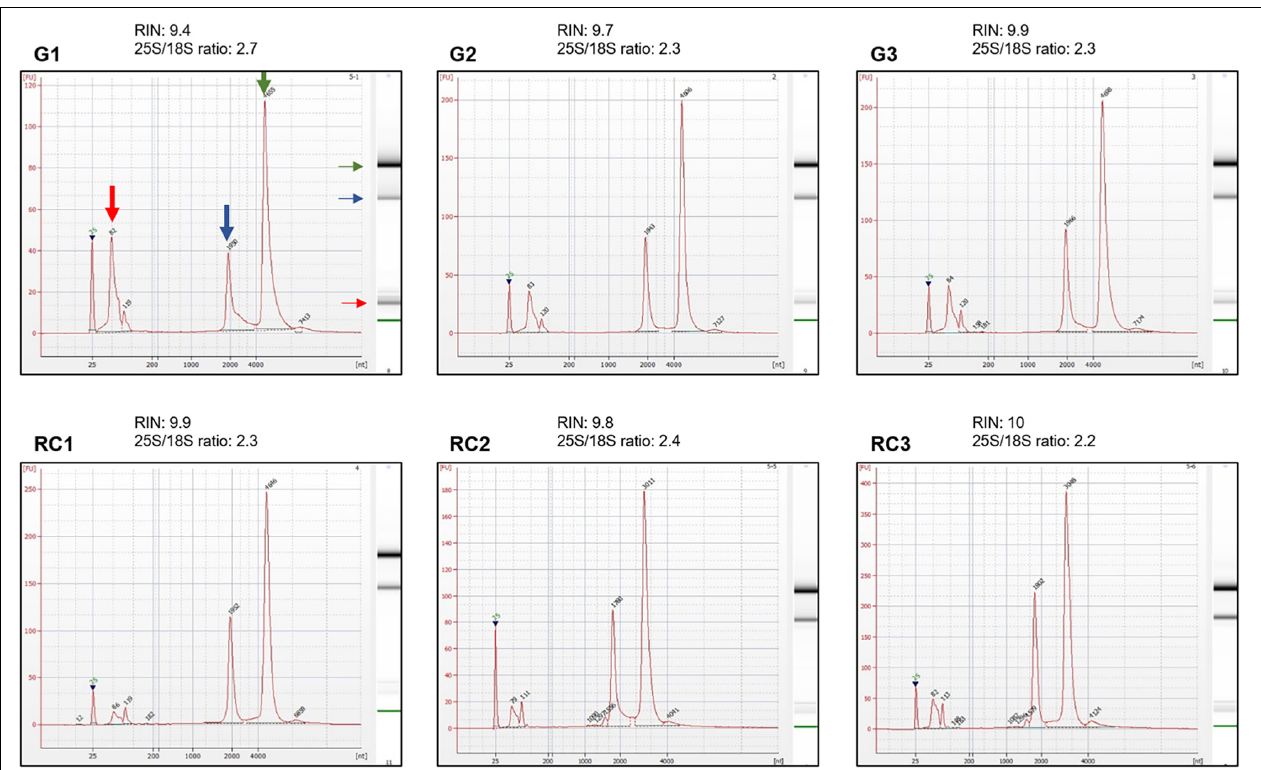
FIGURE 4 | Integrity assessment of RNA samples using electropherograms. Electropherograms of RNA samples for three independent biological replicates of galls, G1–G3, and control roots, RC1–RC3, at 14 days post infection (dpi). Standard size ladder in nucleotides (nt) is shown at the X -axis at the bottom of each graph. FU, fluorescent units at the Y -axis. The electrophoresis column generated by the program is located at the right side of each sample graph. Red arrow indicates the peak of small RNAs. The positions of 18 and 25S of the ribosomal RNA are indicated by a blue and green arrow, respectively. The electropherograms were performed by an external company (Macrogen, Inc., South Korea) using an Agilent R (cid:13) 2100 Bioanalyzer, RNA Bioanalyzer Pico 6000 chip (Agilent Technologies, Inc., Santa Clara, CA, United States).